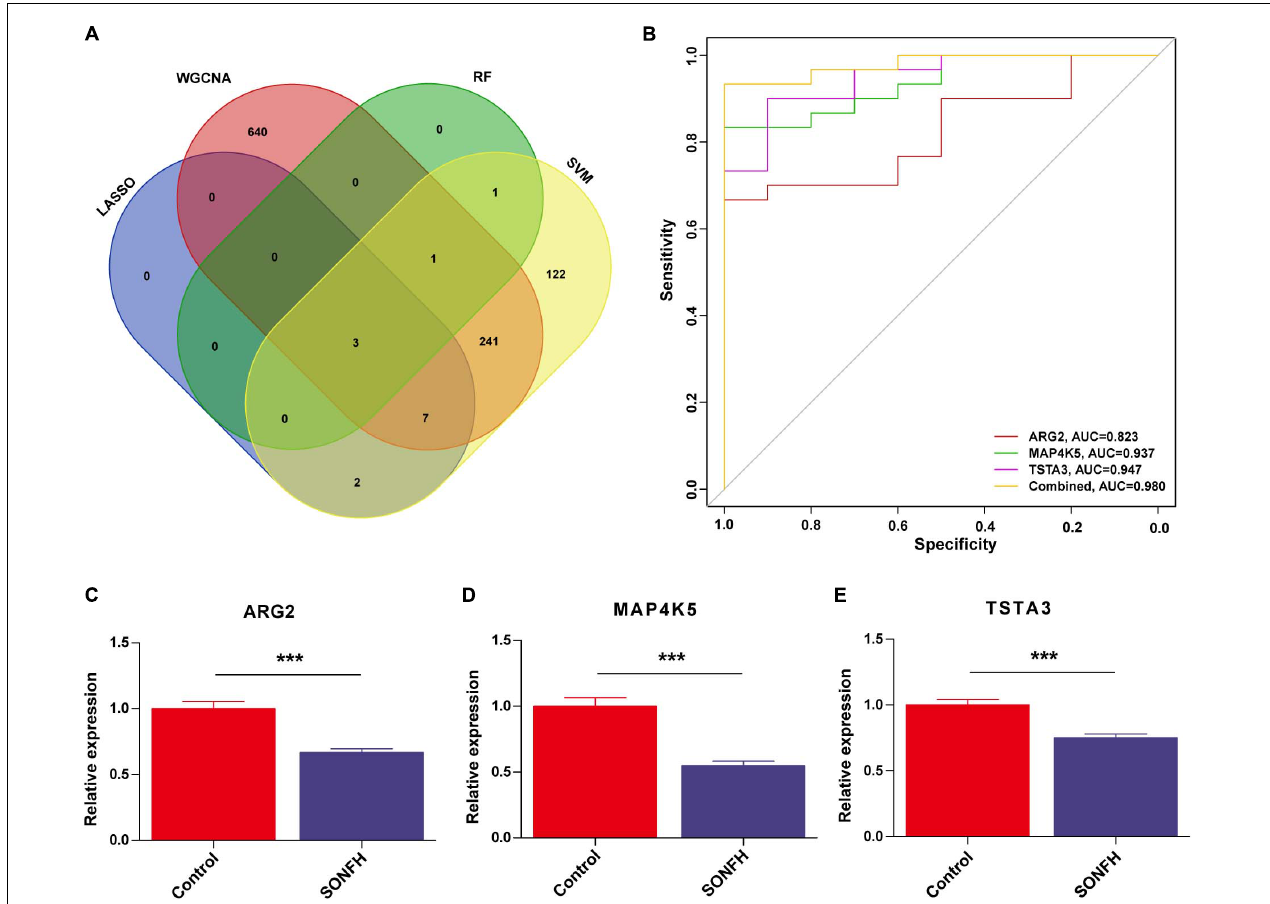
FIGURE 6 | (A) Venn diagram showed the intersection of diagnostic markers obtained by the four algorithms. (B) The ROC curve of the diagnostic efficacy verification after fitting three diagnostic markers to one variable. (C–E) Validation of the expressions of potential diagnostic markers via qRT-PCR. * P < 0.05; ** P < 0.01, *** P <